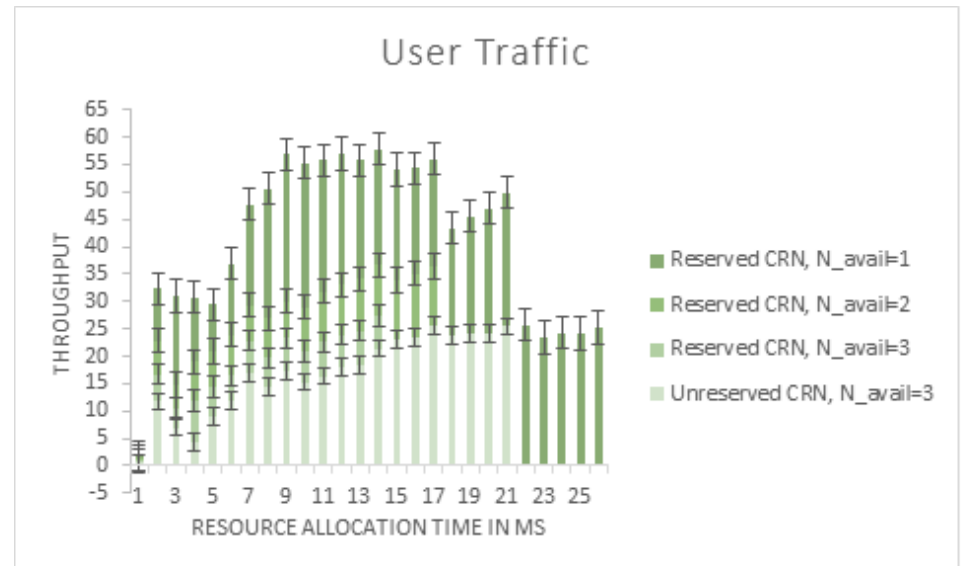
Figure 6. Variation in user traffic with respect to channel reservation time (slice request).